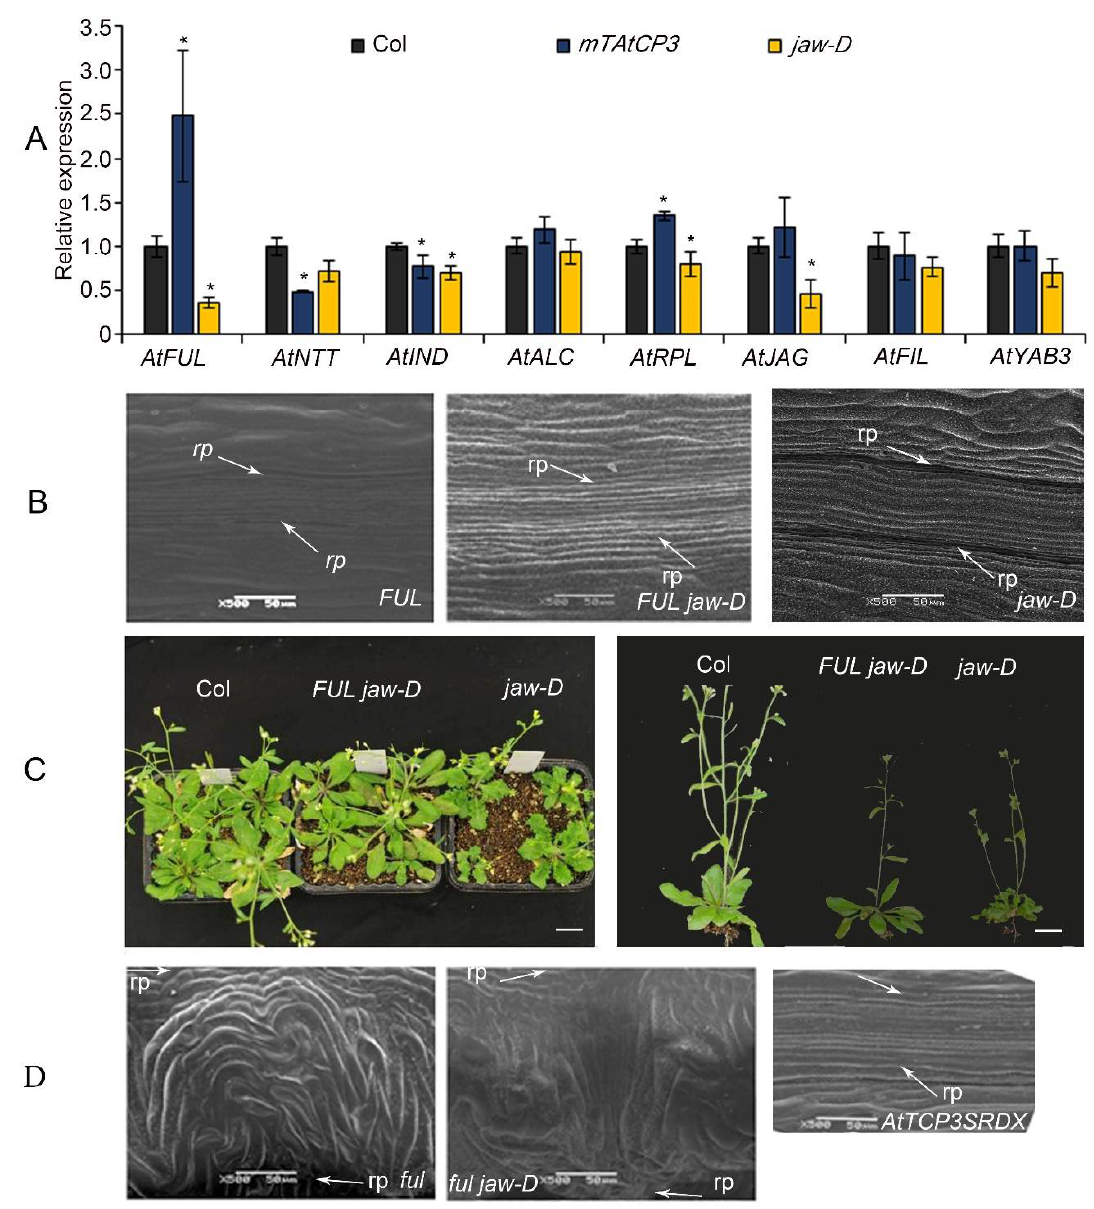
Figure 4. The relationship of miR319a and AtTCP3 with replum- and valve-related genes. ( A ) Real- time PCR showing the relative expression levels of AtFUL , AtNTT , AtIND , AtALC , AtRPL , AtJAG , AtFIL , and AtYAB3 in p35S::mAtTCP3 and jaw-D siliques. ( B ) SEM images showing repla in the si- liques of FUL and FUL jaw-D plants ( p35S::AtFUL in jaw-D mutant). ( C ) The phenotypes of FUL jaw-D plants. ( D ) SEM images showing repla in siliques of ful , ful jaw-D , and pAtTCP3::AtTCP3SRDX plants. AtTCP3SRDX indicates pAtTCP3:: AtTCP3SRDX . The relative transcript level of each gene was normalized to Actin cDNA for quantification. Error bars indicate the standard errors. The asterisks indicate a significant difference (* p < 0.05).